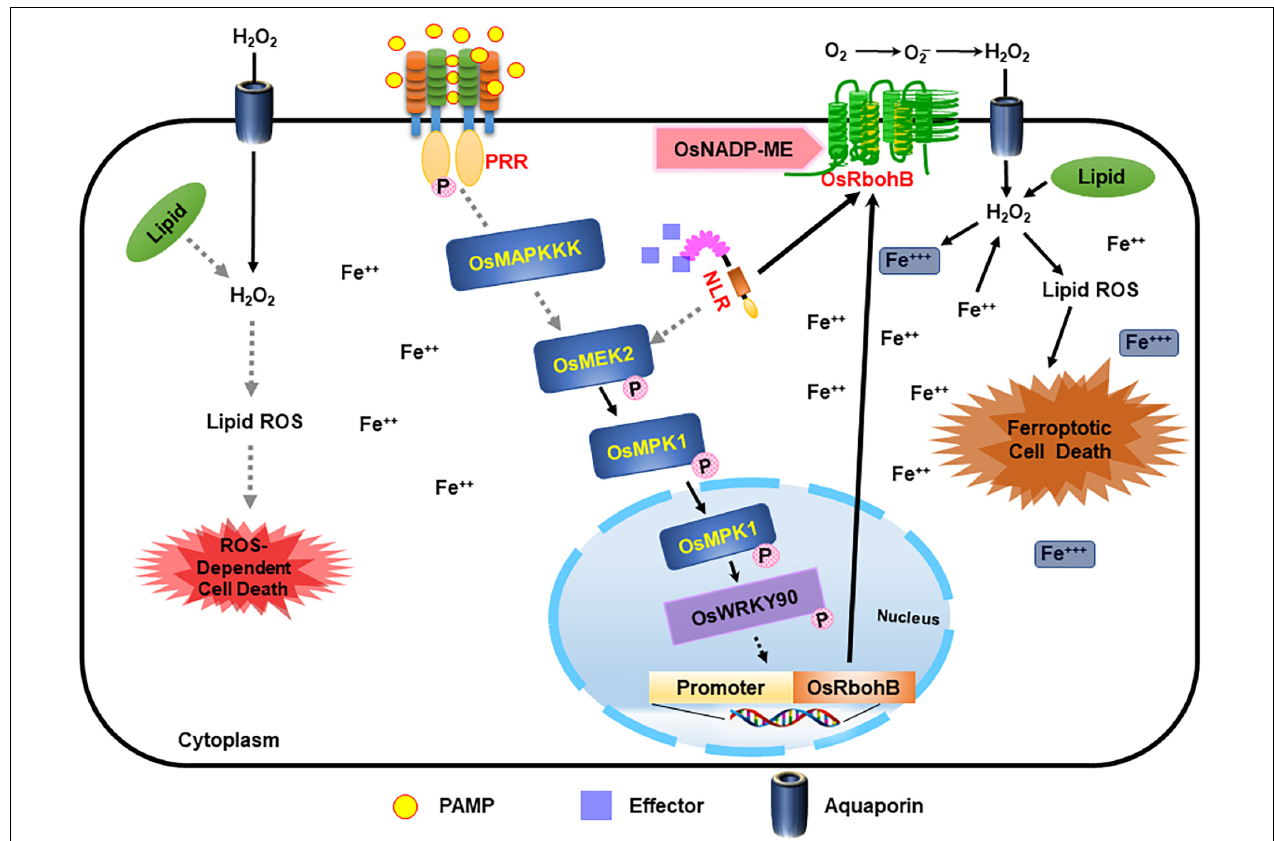
FIGURE 12 | Proposed model of rice MAP kinase kinase 2 (OsMEK2) signaling pathways leading to iron- and ROS-dependent ferroptotic cell death in incompatible rice– Magnaporthe oryzae interactions. M. oryzae invasion in rice cells activates rice MAP kinase kinase 2 (OsMEK2) via different hypothesized signaling pathways (gray dotted lines). The perception of PAMPs or pathogen effectors via membrane-bound PRRs or NLRs, respectively, activates MAP kinases in plant cells. Active OsMEK2 triggers OsMPK1-OsWRKY90 pathways in the nucleus, which may lead to upregulation of NADP-malic enzyme (ME) and NADPH-oxidase ( OsRbohB ). The de novo synthesis of OsRbohB and its trafficking to the plasma membrane contributes to iron- and ROS-dependent ferroptotic death in rice cells. Disease (susceptibility)-related cell death is ROS-dependent and iron-independent in the compatible (cid:49) Osmek2 – M. oryzae interaction. MEK, mitogen-activated protein kinase kinase; MPK, mitogen-activated protein kinase; NADP-ME, NADP-malic enzyme; NLR, nucleotide-binding leucine-rich repeat; PAMP, pathogen-associated molecular pattern; PRR, pattern recognition receptor; WRKY, tryptophan (W), arginine (R), lysine (K), tyrosine (Y) transcription factor.